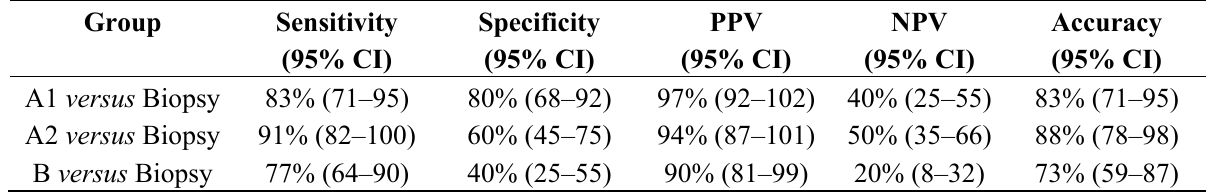
Table 5. Evaluation of the visual interpretation of the contrast-enhancement compared to biopsy as gold standard. Positive predictive value = PPV, negative predictive value = NPV.